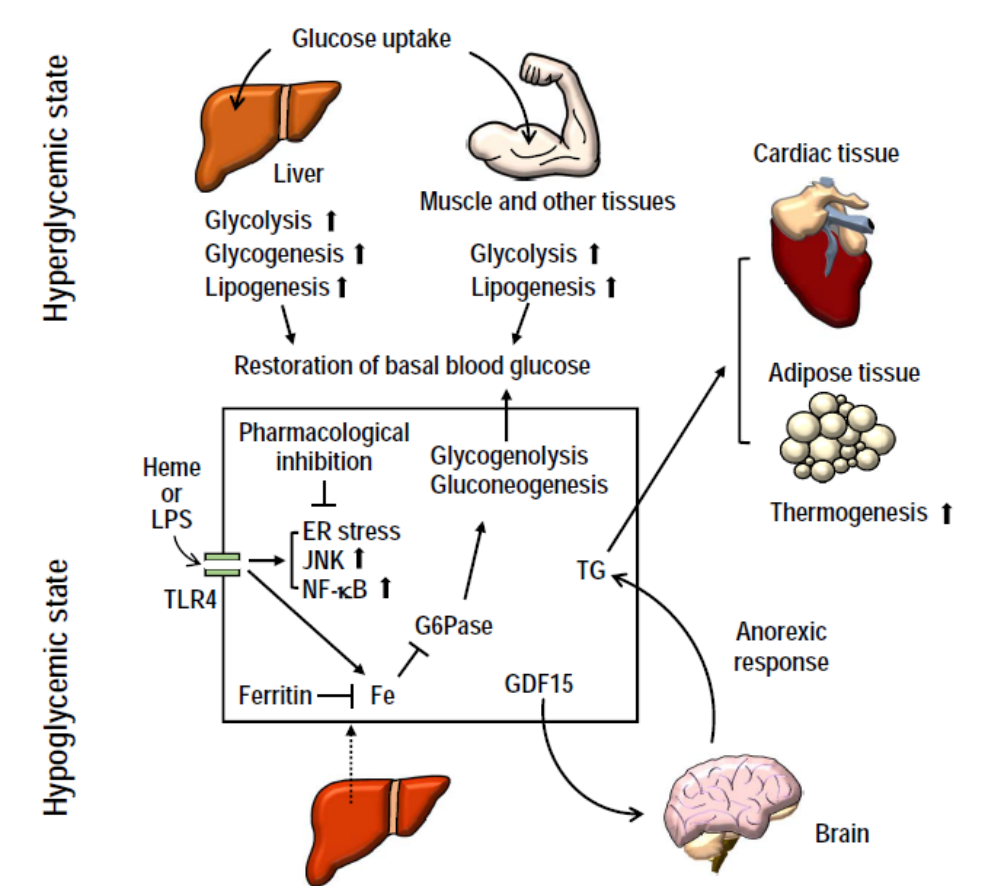
Figure 1. Glucose and triglyceride metabolism in the maintenance of tissue tolerance in sepsis. Maintaining normal blood glucose levels is important for survival in sepsis. To correct hyperglycemia in the early stages of sepsis, glucose uptake in liver and other tissues such as muscles is enhanced. At a later stage in sepsis, lethal hypoglycemia may develop. Tolerance mechanisms such as the sequestration of iron (Fe) ions by ferritin, and inhibition of ER stress and inflammatory pathways sustain G6Pase levels ensuring hepatic glucose production and output for peripheral utilization. Additionally, infection- induced anorexic response causes a switch in energy substrate from glucose to triglyceride. Endocrine communication via the brain – liver axis results in hepatic triglyceride production which maintains the function of cardiac and adipose tissue.